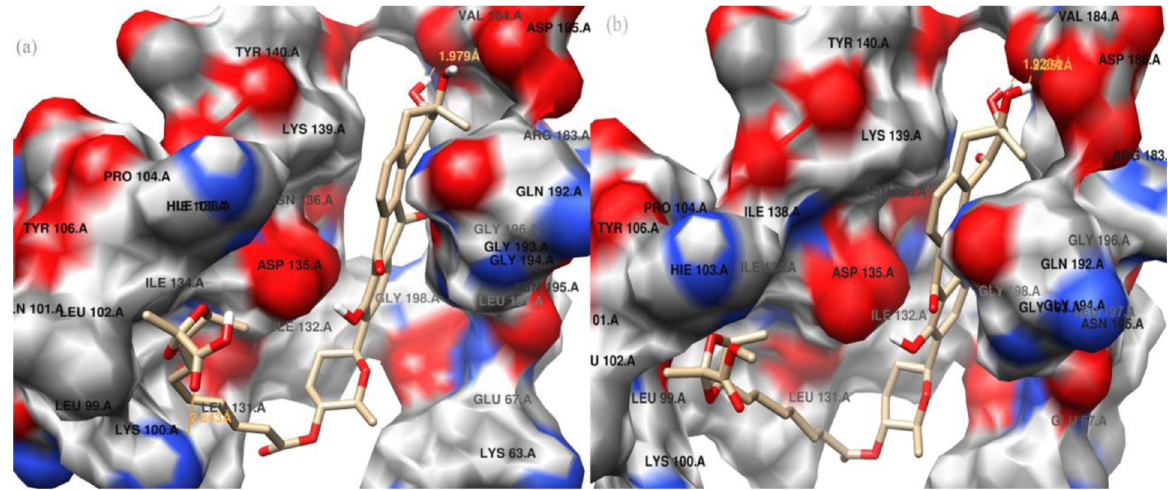
Fig 6. Docking results of homolog modeling. Binding conformations of waldiomycin (a) and waldiomycin methyl ester (b) at the binding site of the homolog model of S . aureus HK/WalK.